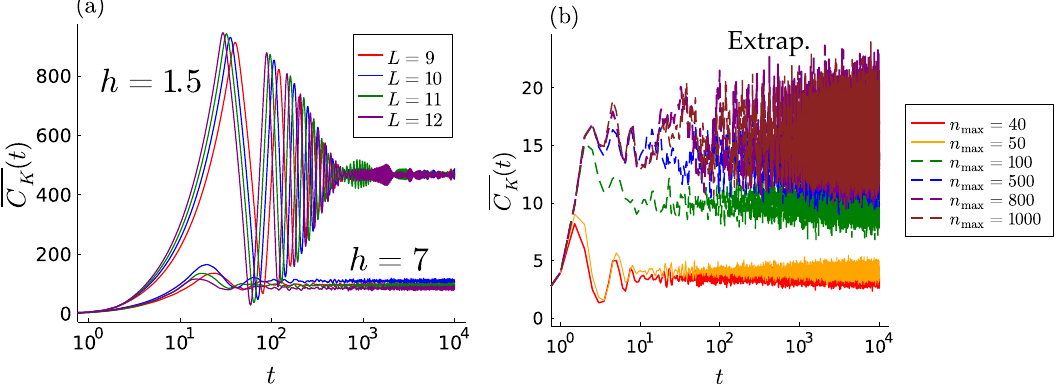
( t ) for the Krylov order K ( t ) in the ergodic K ( t ) stays small relative to n = 1000 K max ( t ) from K . max